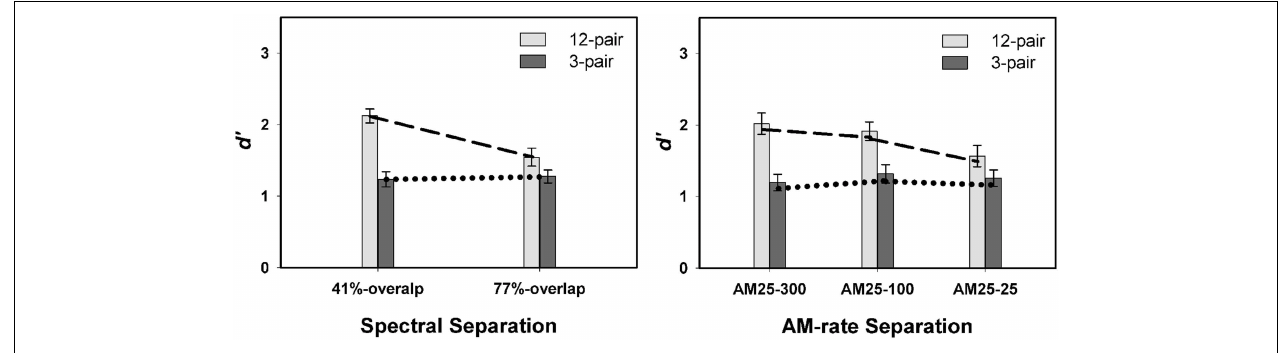
FIGURE 5 | Contrasts of mean d ′ -values between 12-pair and 3-pair stimulus sequences in Experiment 2 for the two spectral separations (left panel) and the three AM-rate separations (right panel) (error bars